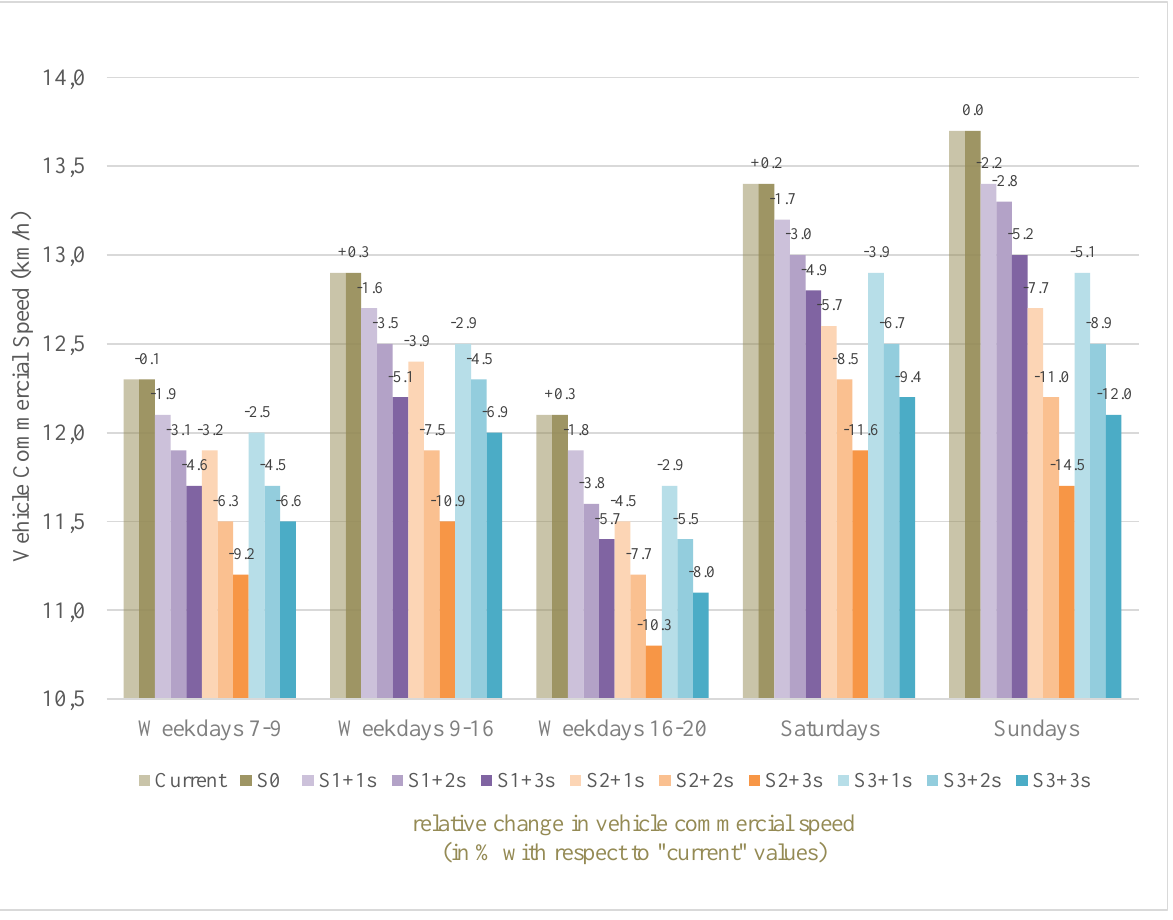
Figure 3. Vehicle commercial speed and its relative change for different